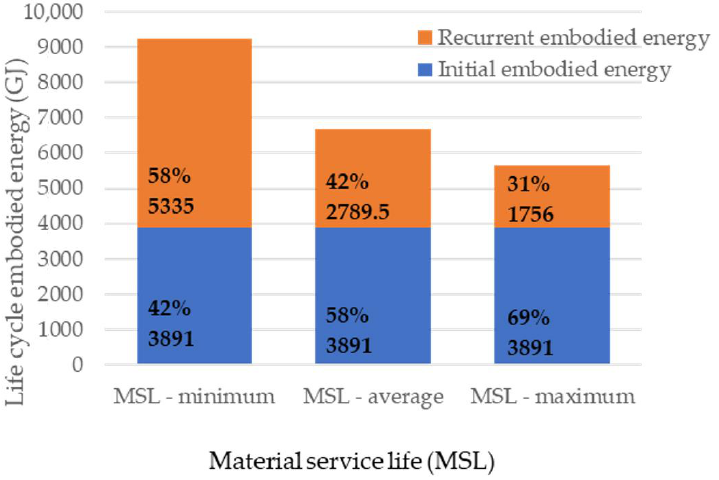
Figure 5. Life cycle embodied energy of the case study house with the minimum, average and maximum material service life over 50 years.